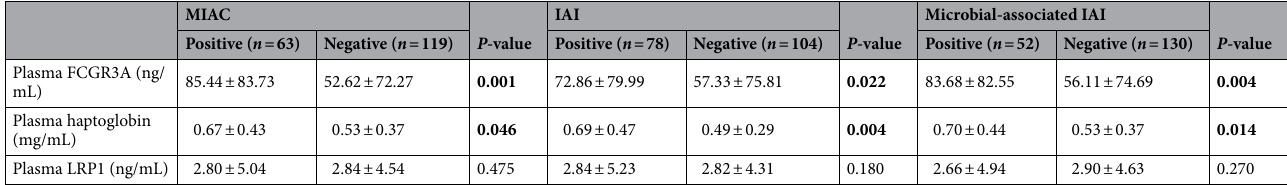
Table 1. Various plasma proteins of the study population according to the presence or absence of microbial invasion of the amniotic cavity (MIAC), intra-amniotic inflammation (IAI), and microbial-associated IAI in women with preterm premature rupture of membranes. FCGR3A low affinity immunoglobulin gamma Fc region receptor III-A, LRP1 prolow-density lipoprotein receptor-related protein 1. Data are given as mean ± standard deviation. Significant values are in